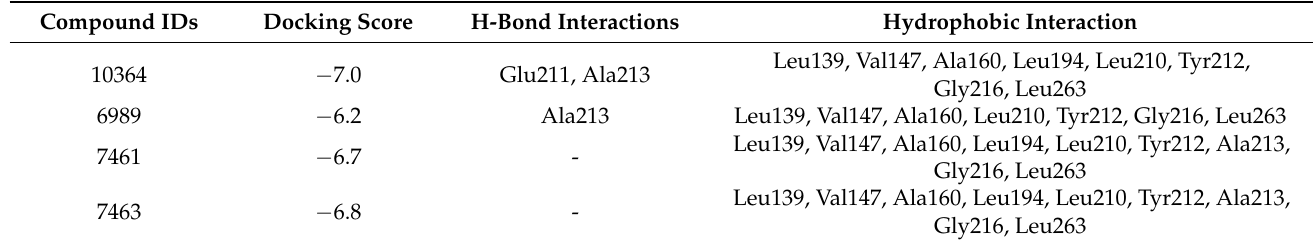
Figure 4. The interactions between AURKA (PDB ID: 3UOD) and OEO main compounds ( A ), OC3 ( B ), carvacrol ( C ), and thymol ( D ). Hydrogen bonds have been labeled using green dashed lines. Table 5. Interactions between OEO compounds and AURKA.